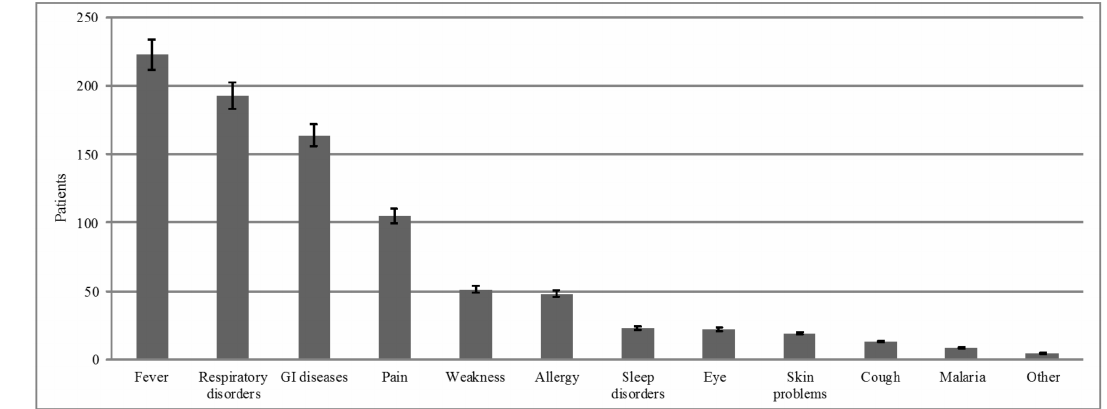
Fig 3. Perception of participants about their